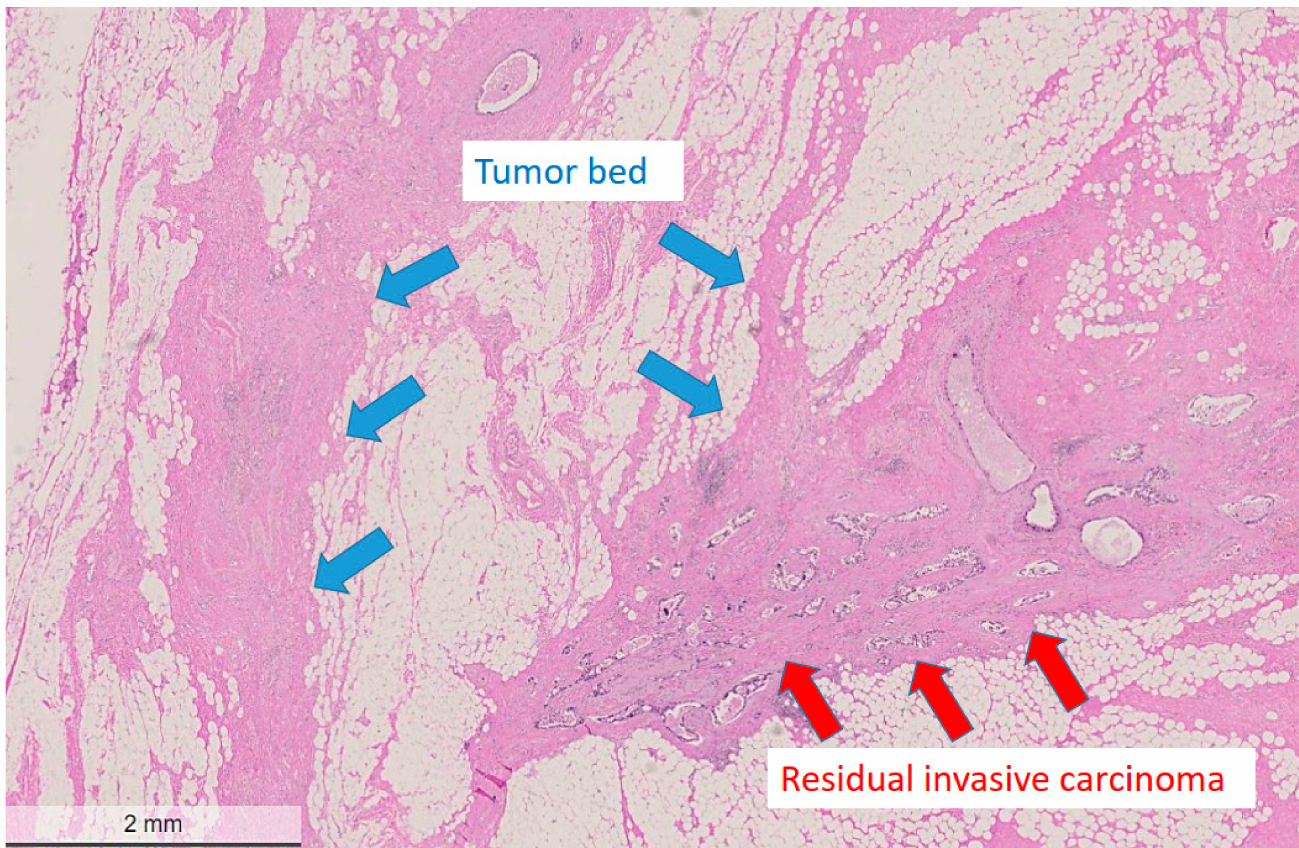
Figure 1. Low power view of a post-treatment breast surgical specimen after partial response to neoadjuvant chemotherapy. The tumor bed area adjacent to residual cancer cells is devoid of residual cancer cells and shows regressive fibrotic changes. The residual tumor cells display one residual measurable focus with a heterogeneous pattern with an estimated reduced cellularity of approximately 50%. Hematoxylin and eosin (H&E) stain, bar: 2